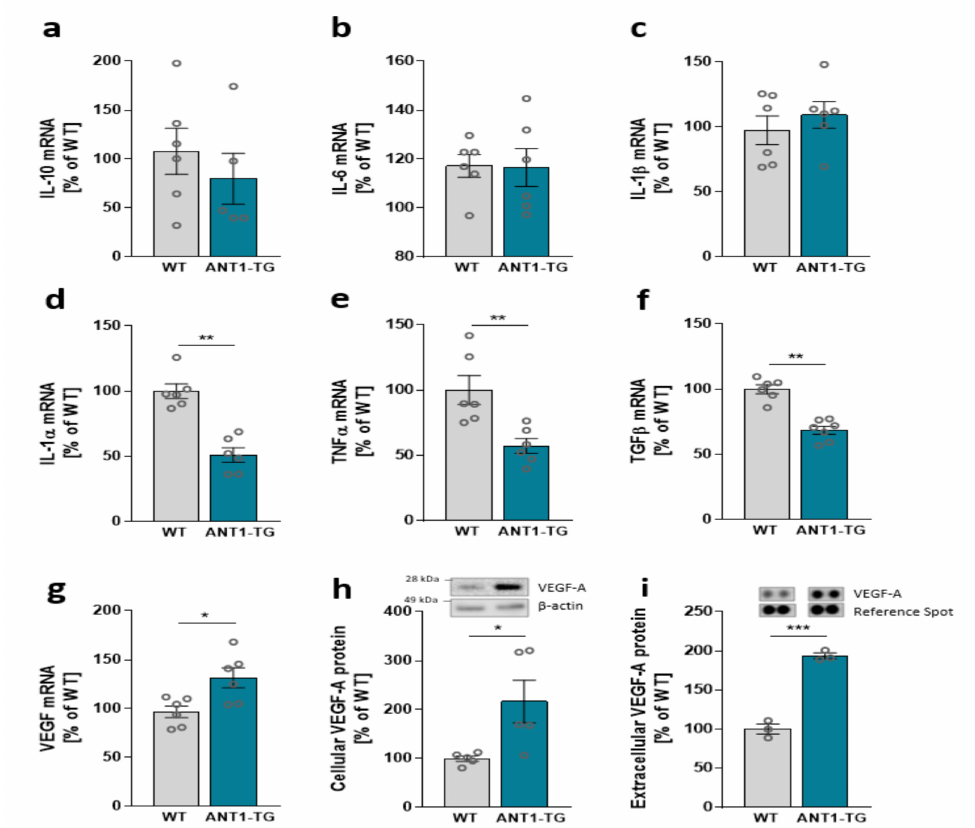
Figure 6. Cytokine mRNA expression levels of ( a ) IL-10, ( b ) IL-6, ( c ) IL-1 β , ( d ) IL-1 α , ( e ) TNF α , ( f ) TGF β , and ( g ) VEGF in WT and ANT1-TG cardiomyocytes. ( h ) VEGF-A protein abundance in WT and ANT1-TG cardiomyocytes and ( i ) levels of VEGF protein released from the cardiomyocytes; upper panels show representative Western or dot blots. Data are presented as the mean ± SEM, * p ≤ 0.05, ** p ≤ 0.01, *** p ≤ 0.001 vs. WT